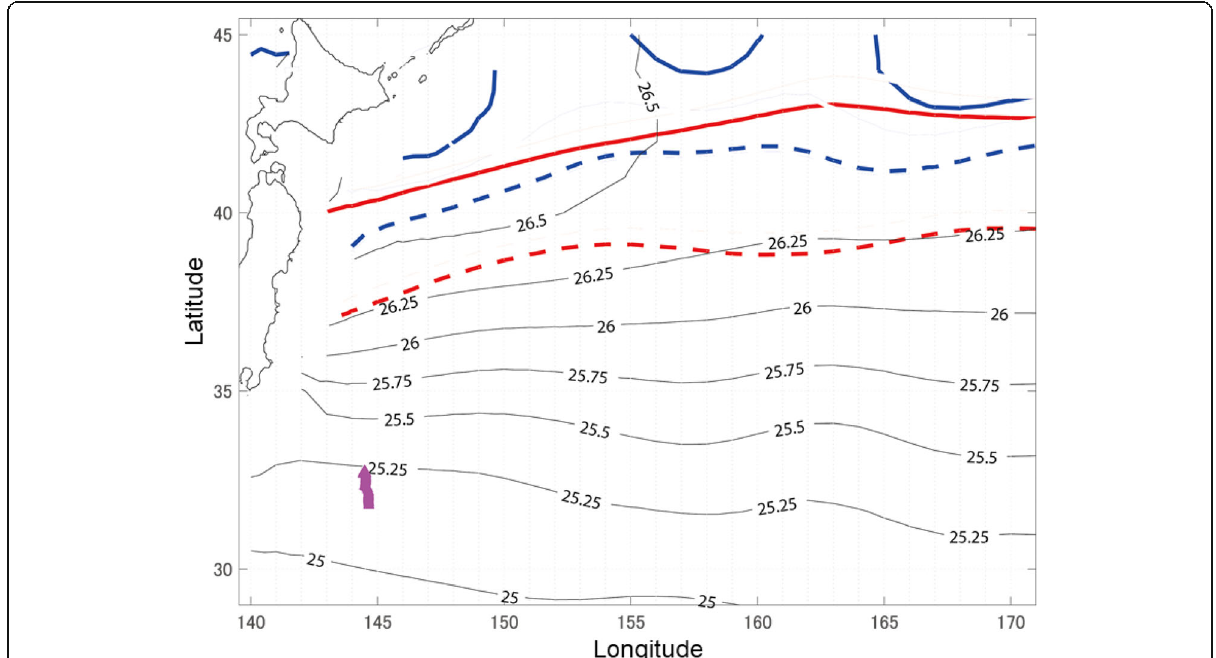
Fig. 8 Red dashed (solid) and blue dashed (solid) lines show surface (50 m depth) mean (minimum) salinity and mean (maximum) saturated oxygen concentration detected in the Seaglider data, respectively, based on March averaged data in the WOA18. Black contours show the outcrop lines of the corresponding isopycnal surfaces. Magenta dots are the Seaglider position during the period when small water parcels are